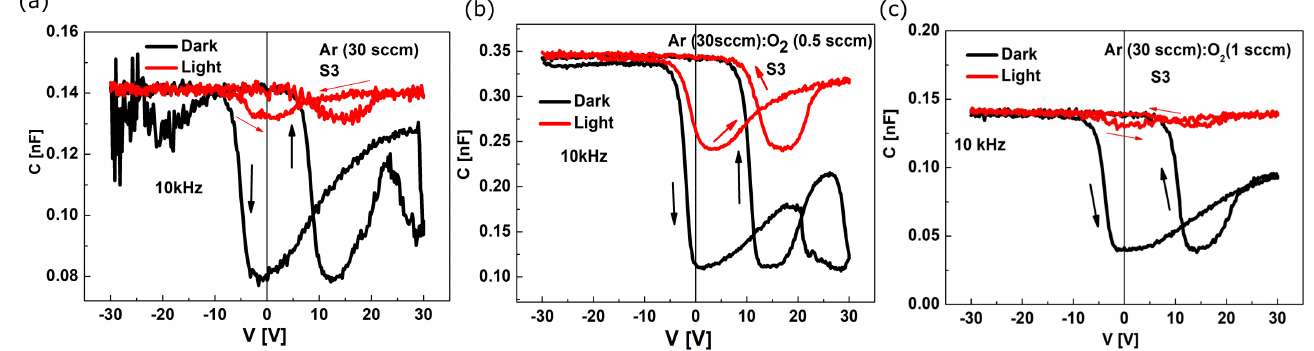
Figure 5. The C − V characteristics of the Si/SiO 2 /V x O y /TiN heterostructures with V x O y films obtained in ( a ), ( b ) and ( c ) conditions ( a – c ). Measurements were performed for heterostructures with S3 = 0.25 mm 2 , at 10 kHz, in conditions of dark (black line) and under white light (red line) illumination. Arrows in the graphs indicate the voltage sweep direction.